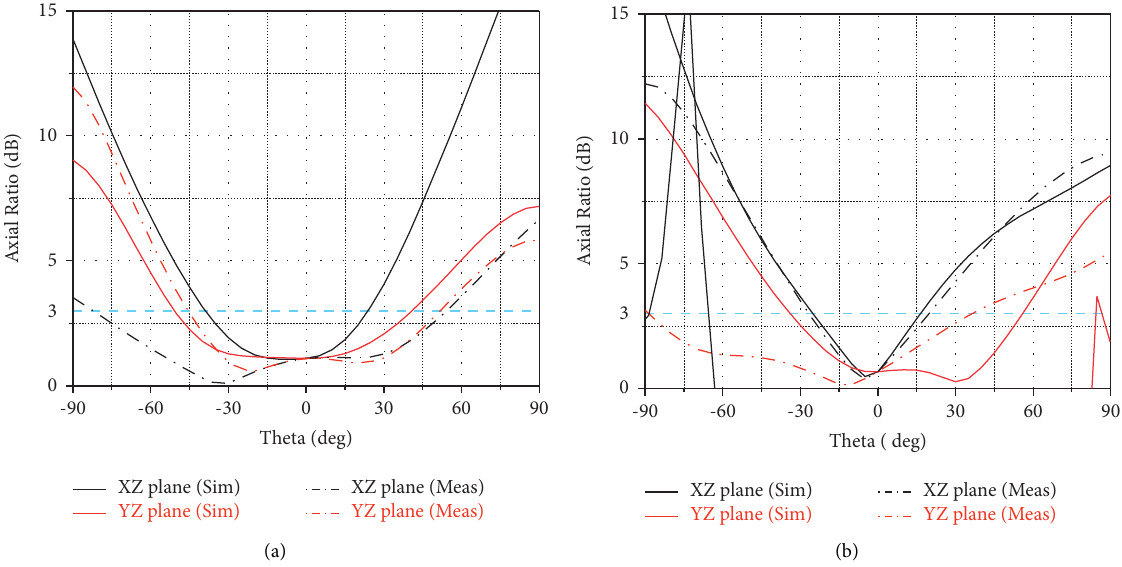
Figure 12: Simulated and measured axial ratio as a function of θ angle from the broadside, in the XZ and YZ planes at 0.915GHz: (a) Port 1 and (b) Port